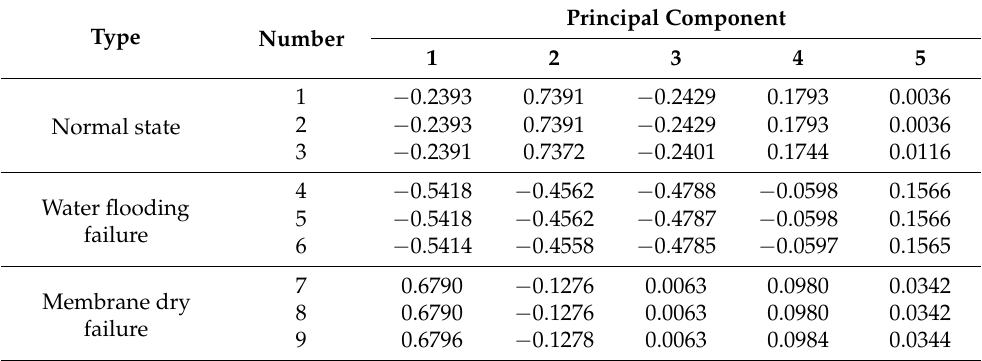
Table 3. Characteristic data with KPCA dimension reduction.